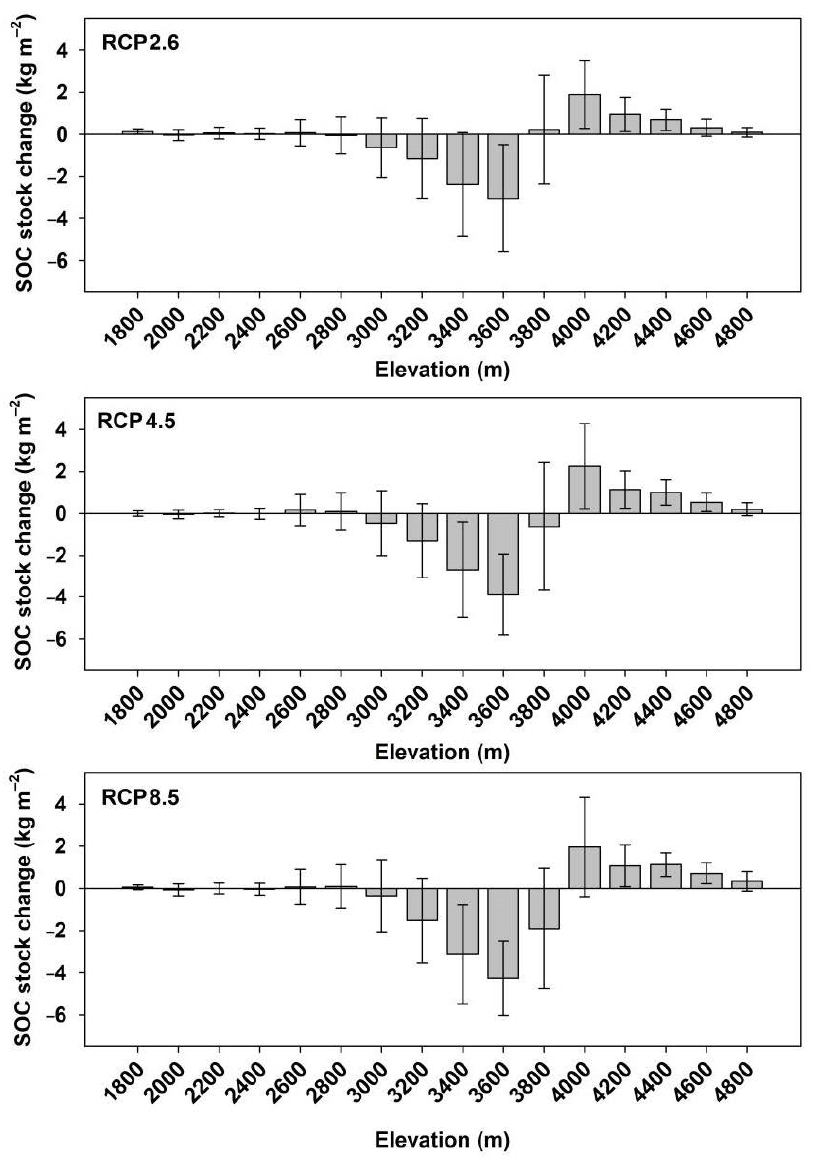
Figure 11. SOC stock changes along the elevation gradient from the 2000s to the 2050s under the RCP2.6, RCP4.5 and RCP8.5 scenarios. Table 3. Summary of SOC stock changes by vegetation types under different climate change scenarios from the 2000s to the 2050s.